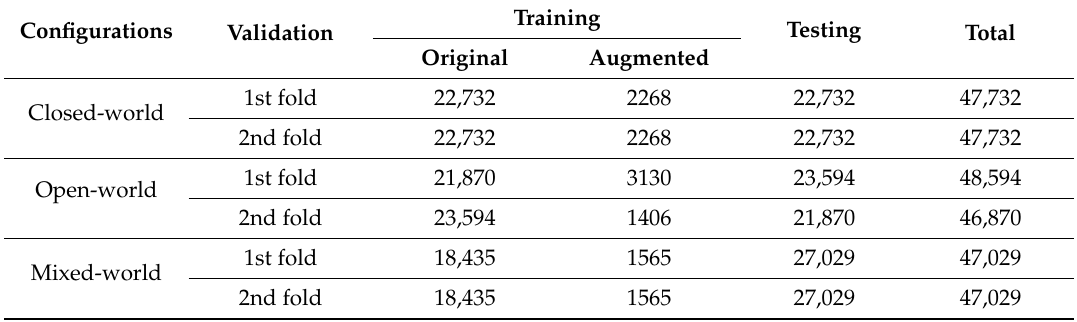
Table 4. Class imbalance details with augmented images for the classes which contain less than 500 images in training (unit: images).